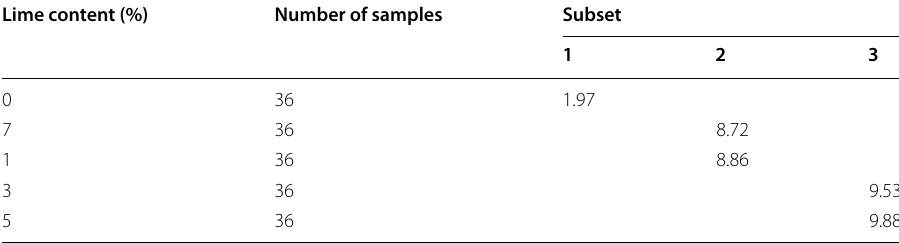
Table 8 Effect of lime content on mean of compressive strength of treatments Lime content (%)